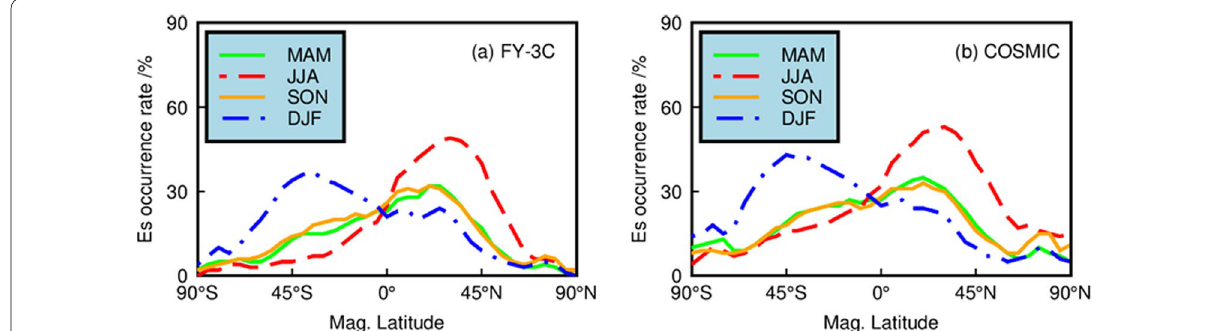
Fig. 12 The zonal distribution of the Es occurrence rates derived from a FY-3C RO data and b COSMIC RO data in the four different seasons during Jan 2015 to Dec